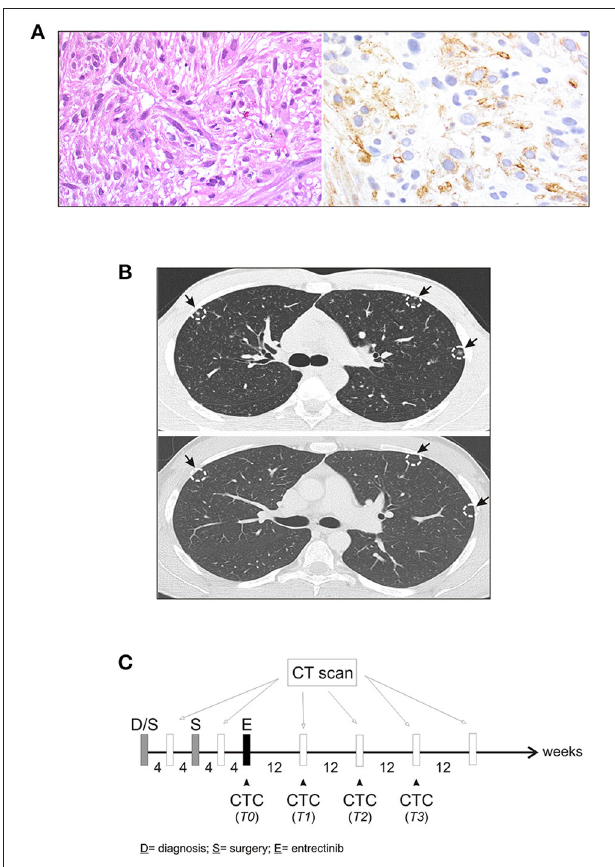
FIGURE 1 | Characteristics of IMT. (A) Fascicular proliferation of monotonous spindle cells within myxoid stroma ( left ), and immunohistochemical staining with anti-ALK antibody ( right ). (B) Computed tomography (CT) scan before initiating entrectinib ( top ), and after 9 months of entrectinib ( bottom ). Arrows indicate lung micronodules. (C) Workflow for CT scan and longitudinal CTCs collection during treatment.